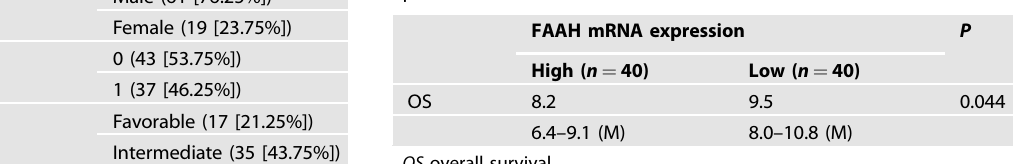
Table 3. FAAH expression and clinical outcome of advanced RCC